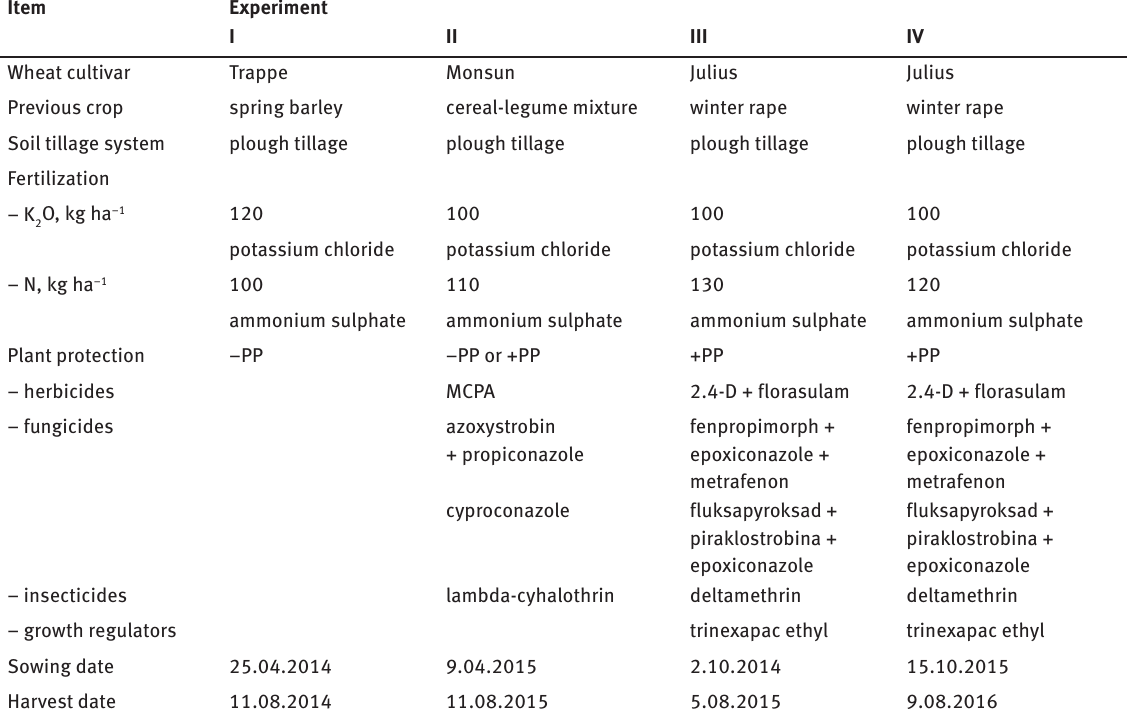
Table 5: Basic agricultural data for the experiments.